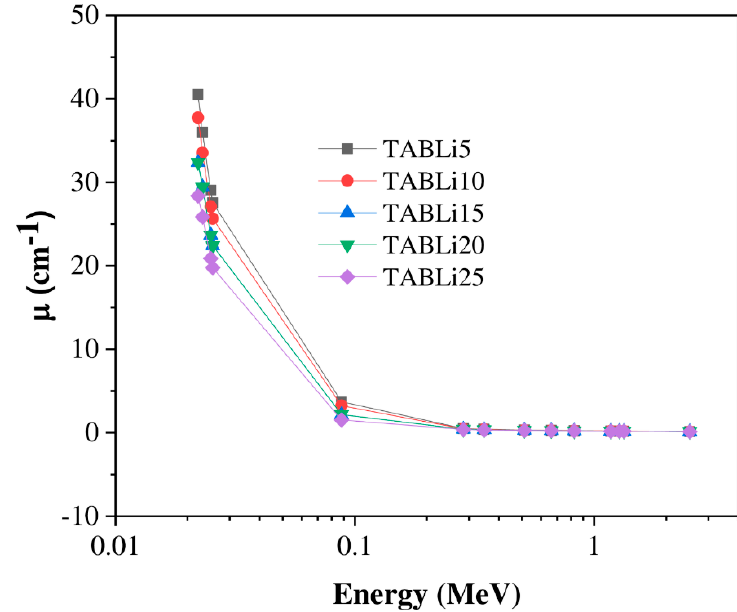
Figure 8. The studied glasses’ linear attenuation coefficient vs the energy.